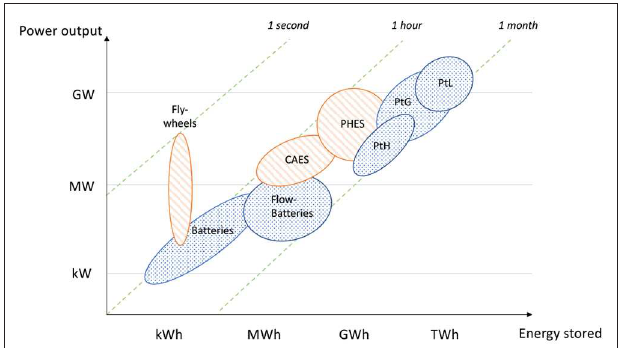
FIGURE 1 | Link between the restituted electrical power and the stored energy capacity for different storage techniques: mechanical storage in orange and chemical storage in blue—based on Limpens and Jeanmart